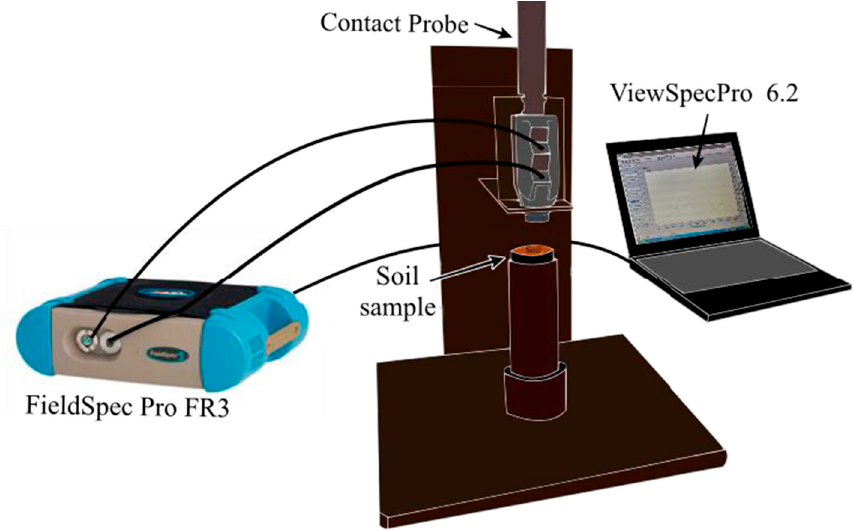
Figure 3. Data acquisition geometry. Adapted from [45].